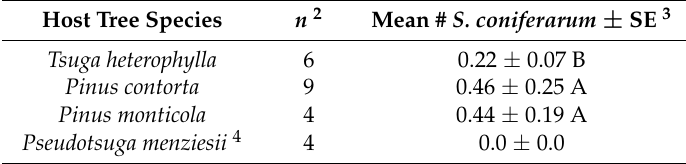
Table 2. Mean S. coniferarum recovery (±SE) via beat-sheet sampling on different host tree species in Tacoma, WA, USA from October 2015 – November 2016 1 . Values not sharing a similar letter are significantly different ( P < 0.05).